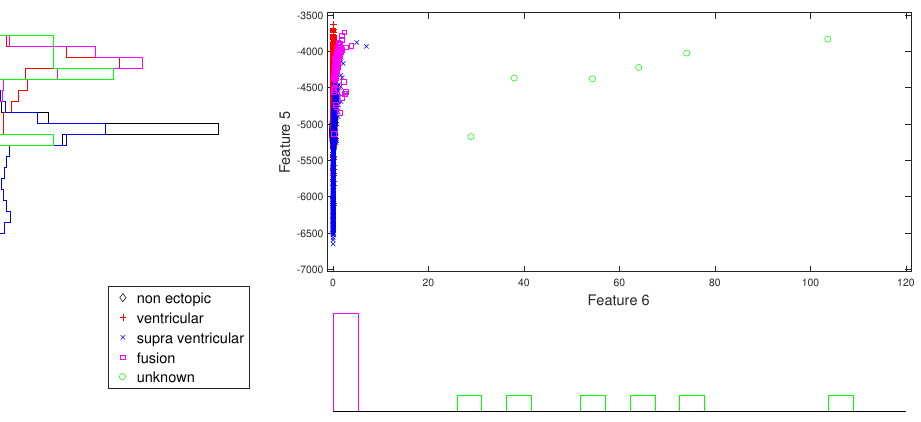
Figure 8. Scatter plot with marginal histogram for norm entropy (IMF1) vs. log entropy